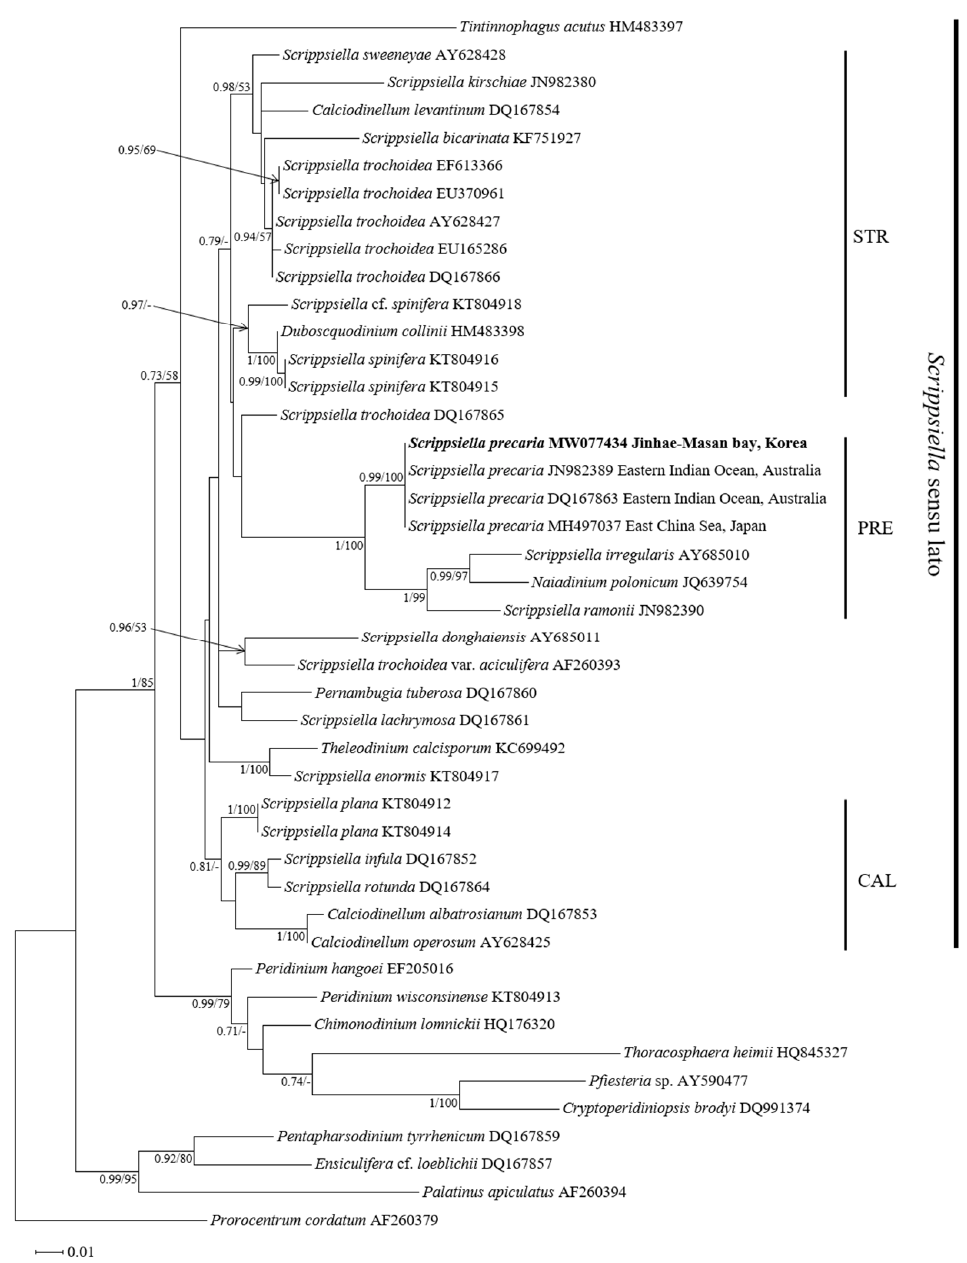
Figure 7. Phylogenetic positions of Korean isolates of Scrippsiella precaria that were inferred from the LSU rDNA sequences based on maximum likelihood (ML). The numbers on each node are the Bayesian posterior probability (PP) followed by the bootstrap values (%). Only bootstrap values above 50% and PP above 0.7 are shown. CAL: clade of Calciodinellum and its relatives, STR: clade of S. trochoidea and its relatives, PRE: clade of S. precaria and its relatives. These clades were based on the results of Gottschling et al. [18] and Luo et al. [15]. Scale bar: 0.01 nucleotide substitutions per site.